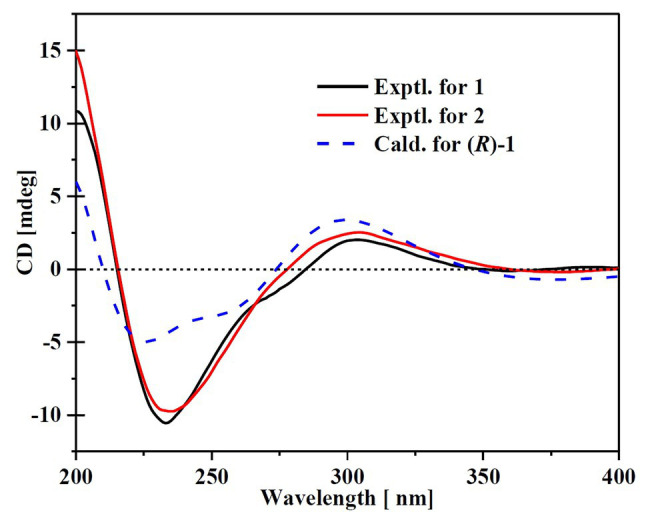
Experimental ECD of the compounds 1 and 2 and the calculated spectrum for (7R)-1.